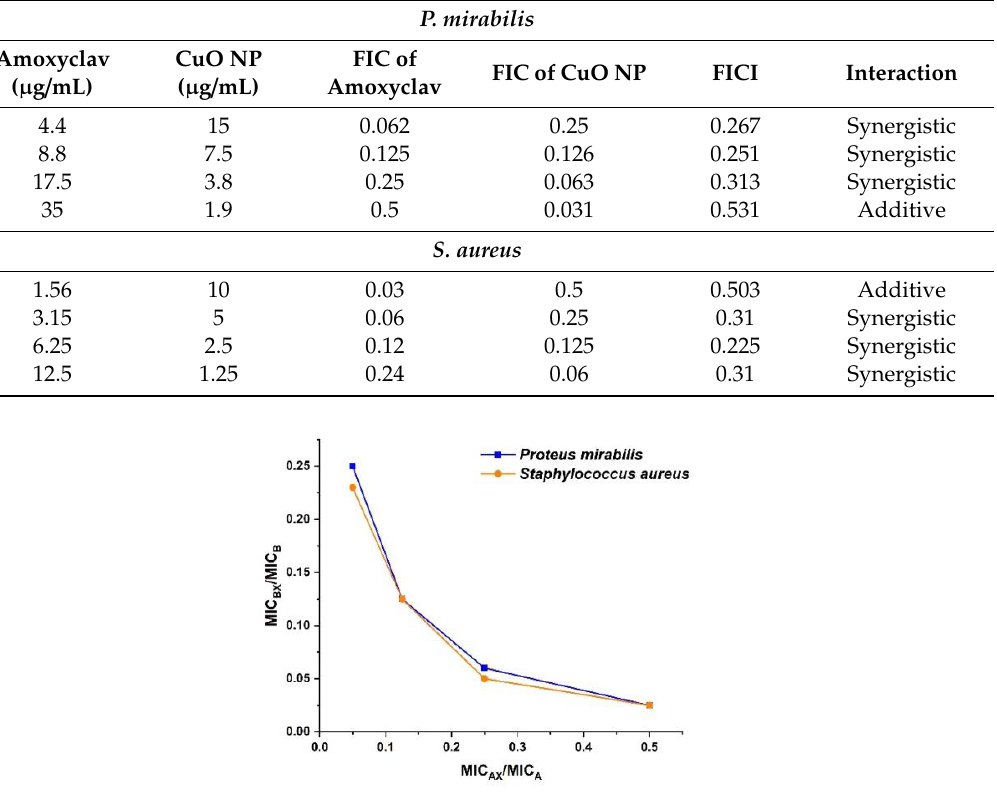
Figure 3. Synergy between amoxyclav and CuO NPs.